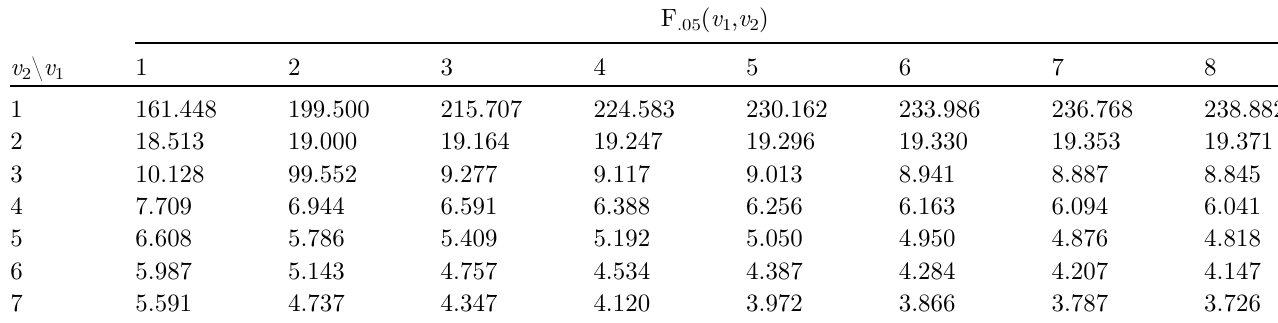
Table 6. Extract from the Fisher